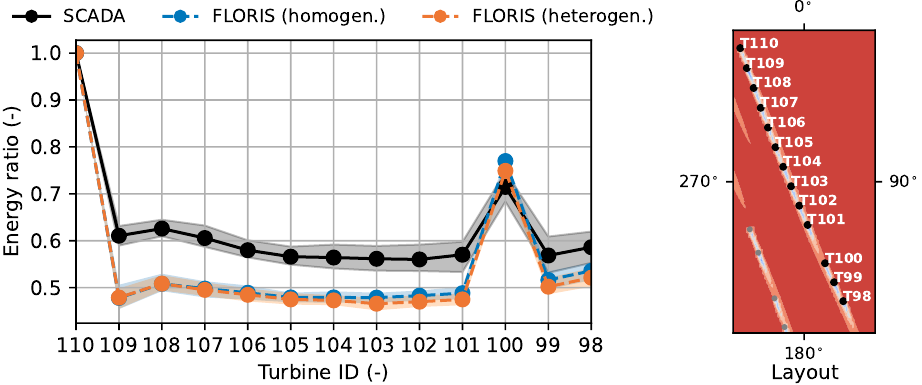
Figure 11. Energy ratios of Turbines 0 through 10 for the Anholt wind farm for a narrow wind direction sector of 172.1 ◦ to 187.1 ◦ . Turbine 0 acts as the reference turbine, and the reference wind direction is the average of the wind direction measurements of the array of turbines. The shaded regions represent 90% confidence interval bounds obtained through bootstrapping. The layout schematic on the right shows the location of Turbines 0 through 10 in the wind farm.